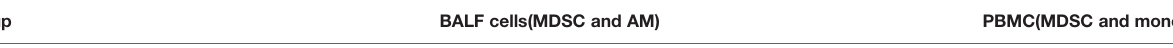
TABLE 2 | Sample set selection. Group BALF cells(MDSC and